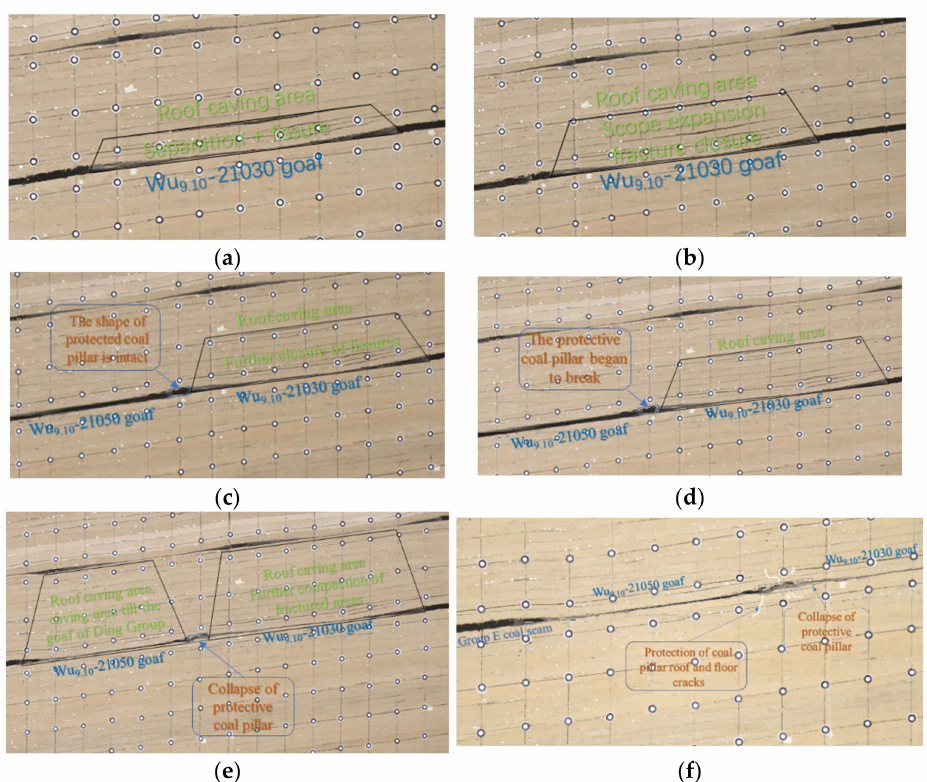
Figure 5. Drawing of roof caving and displacement in mining of Group E coal seam: ( a ) Wu 9.10-21030 working face advancing 197.6 m; ( b ) Wu 9.10-21030 working face advancing 208 m; ( c ) Wu 9.10-21050 working face advancing 124.8 m; ( d ) Wu 9.10-21050 working face advanc- ing 135.2 m; ( e ) Wu 9.10-21050 working face advancing 145.6 m; and ( f ) partial drawing of coal pillar collapse.